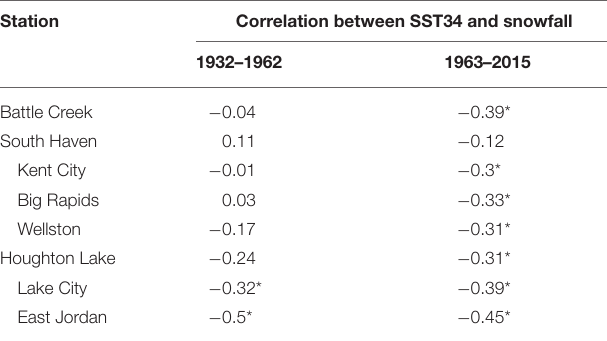
TABLE 3 | Pearson’s correlations coefficients ( r ) between SST34 and snowfall for the periods of 1932–1962 and 1963–2015 at the stations. Station Correlation between SST34 and